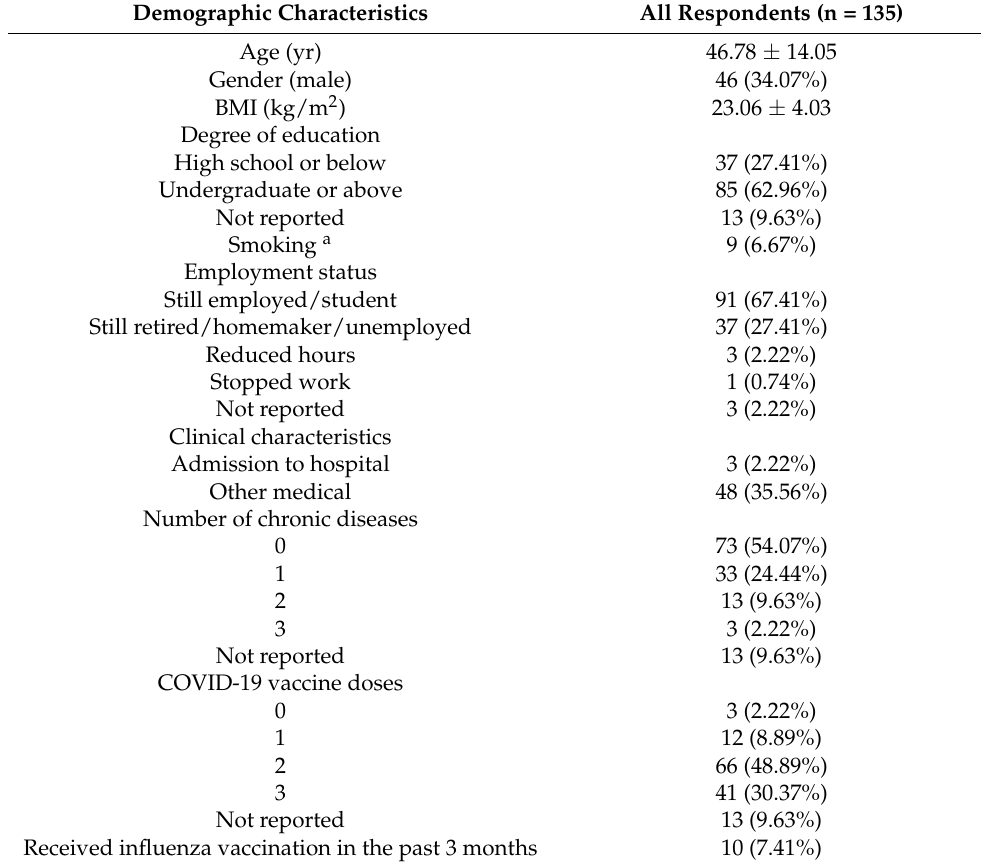
Table 1. Baseline characteristics of respondents.